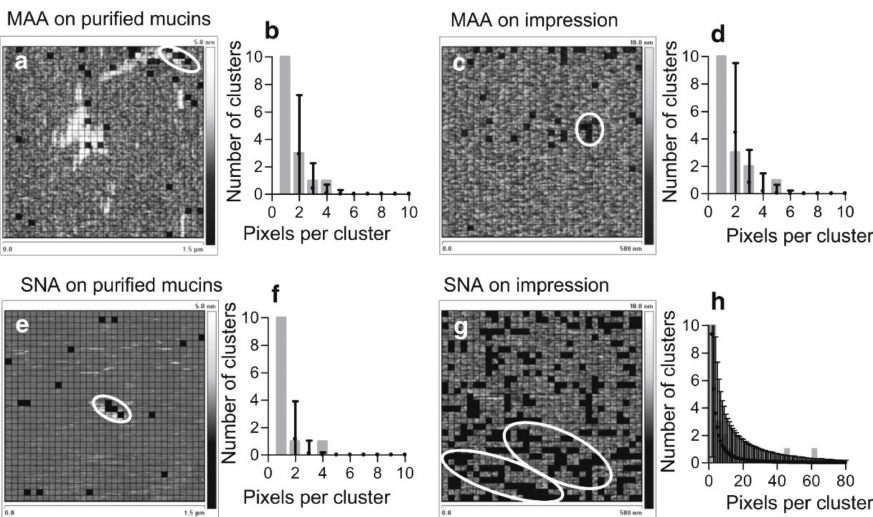
Figure 5. Glycan clustering probed by AFM surface topography and affinity mapping. AFM tips were functionalized with lectins Maackia amurensis (MAA) and Sambucus nigra (SNA), and the interactions with their respective receptors α -2,3 and α -2,6 N -acetylneuraminic (sialic) acids, present at the surface of normal human conjunctival mucins (NHC cells) or ocular cytological impressions, were probed. Force maps present height data overlaid with grids showing the location of specific interactions (solid squares) indicating the location of sialic acids: ( a ) MAA on single molecules, ( c ) MAA on impressions, ( e ) SNA on single molecules, and ( g ) SNA on impressions. The corresponding graphs ( b , d , f , and h ) show the expected number of neighboring interactions (mean ± 3 SD) in a simulated random distribution of equal size. The observed numbers of neighboring interactions are presented as gray bars. These are considered clustered if their number exceeds the mean + 3 SD of the simulated data and are circled in white on the force maps. Reprinted with permissions from